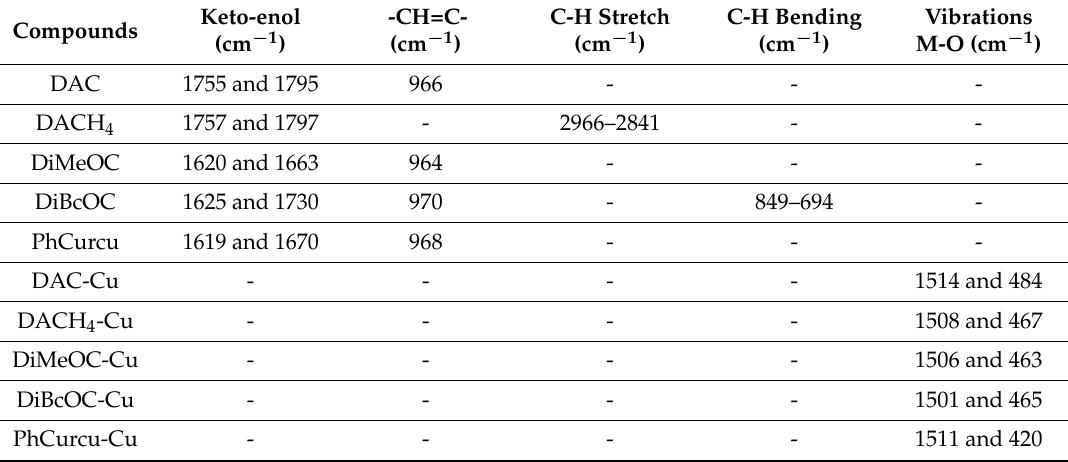
Table 1. IR spectral data of compounds 1 – 10